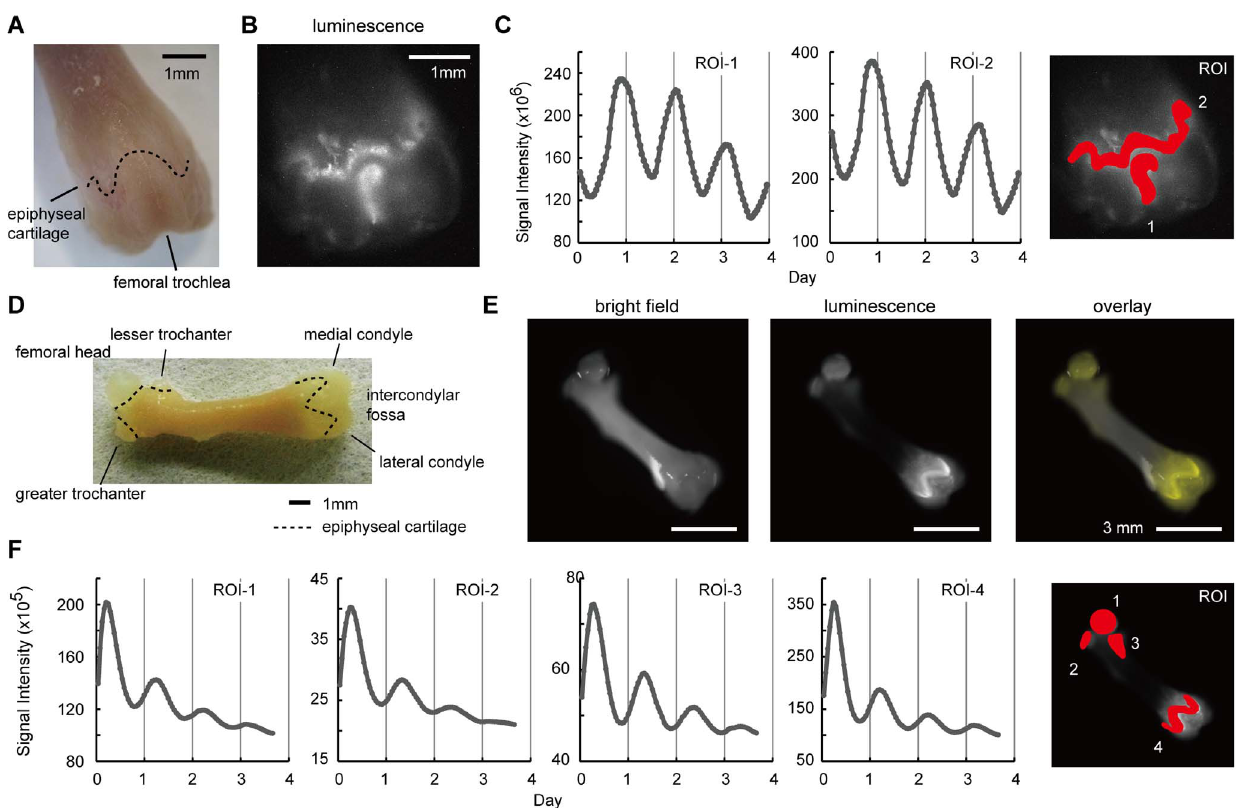
Figure 3. Microscopic observation of the femur. ( A ) The overview of the distal half of the femur. The dotted line indicates epiphyseal cartilage. The mirror-reversed image was used for comparison to the bioluminescence image. A sample was obtained from a 16.5-week old mouse and cultured for 6 days before observation. ( B ) The bioluminescence image obtained by a microscope-based high sensitivity CCD camera system. ( C ) A time series analysis of the epiphyseal cartilage ( ROI-1 ) and femoral trochlea ( ROI-2 ). The right panel shows set ROIs. ( D ) A schematic view of the femur. The dotted line indicates epiphyseal cartilage. A sample was obtained from a 2.4-week old mouse and cultured for 4 days before observation. ( E ) A representative microscopic view of the femur. A bright field ( left ), bioluminescence ( middle ), and overlaid image ( right ) are displayed. For the overlaid image, the bioluminescence signal is shown in yellow. ( F ) A time series analysis of the signal intensity for 88-hours. The right panel shows set ROIs.